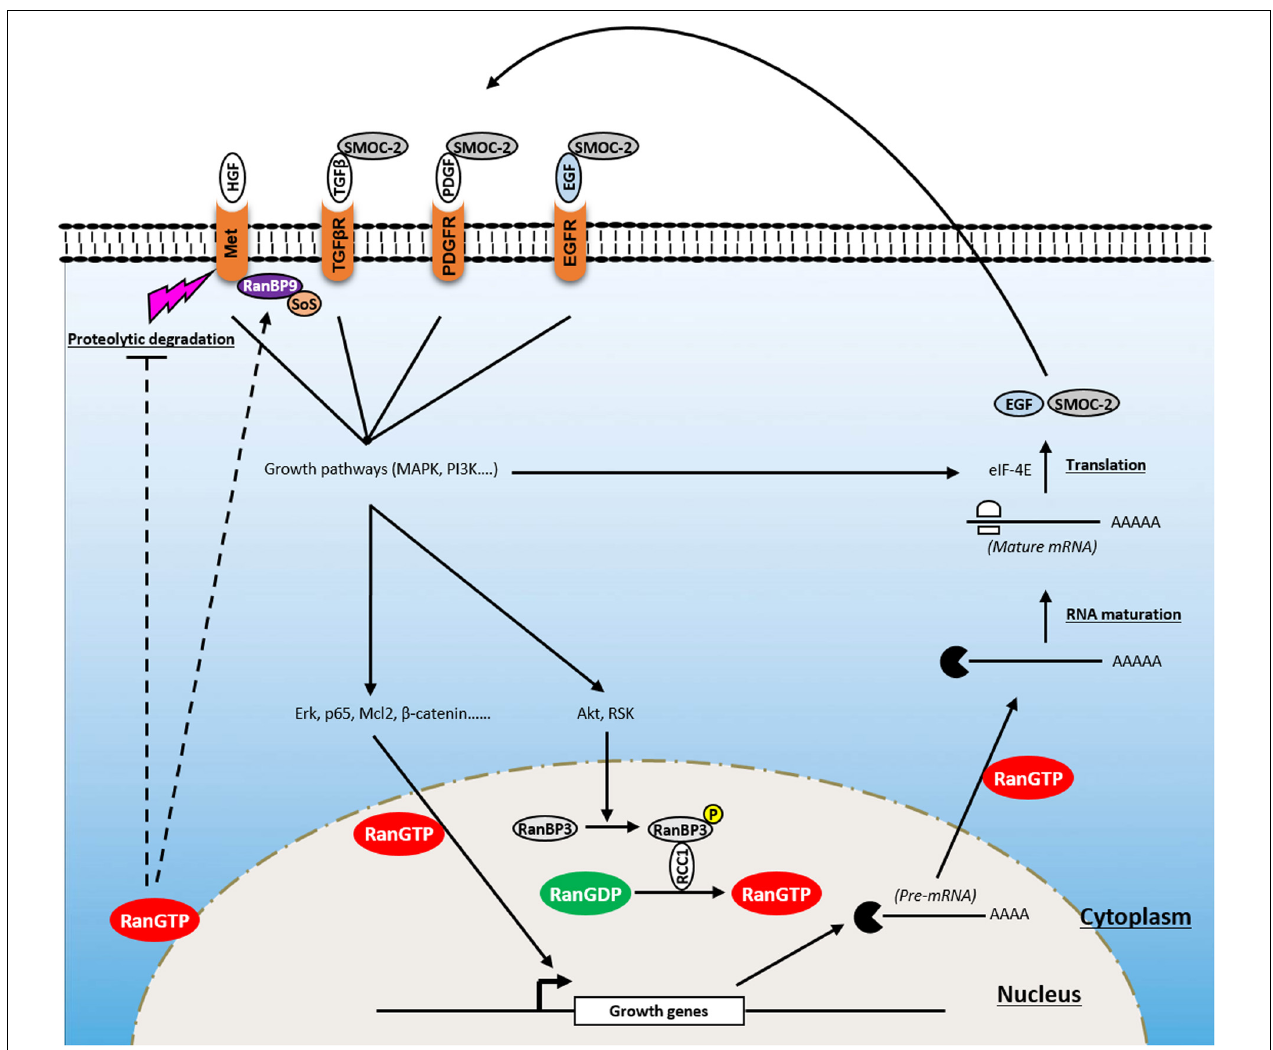
FIGURE 2 | Involvement of Ran in proliferative signaling of cancer cells. Ran is a key player in a positive feedback loop that enhances growth signaling and promotes tumorigenesis. Owing to its ability to affect the import of critical transcription factors (i.e., Erk, p65, Mcl2, β -catenin), RanGTP transmits growth signals from the cytoplasm to the nucleus. RanGTP is also involved in the export of pre-mRNA which are further processed and translated into growth factors [i.e., epidermal growth factor (EGF), SMOC-2) which activate several tyrosine kinase receptors [i.e., EGF receptor (EGFR), platelet-derived growth factor receptor (PDGFR), transforming growth factor beta receptor (TGF β R)] after their release to the extracellular compartment. In addition, Ran is activated following the induction of growth signaling through the phosphorylation of RanBP3 by Akt and ribosomal protein S6 kinase (RSK). Furthermore, besides its ability to modulate the activity of these receptors, Ran is involved in supporting Met signaling through (i) its stabilization by blocking its proteolytic cleavage by metalloproteases and preventing receptor shedding and (ii) the activation of RanBP9 that recruits Son of Sevenless (SoS) which acts upstream of the GTPase